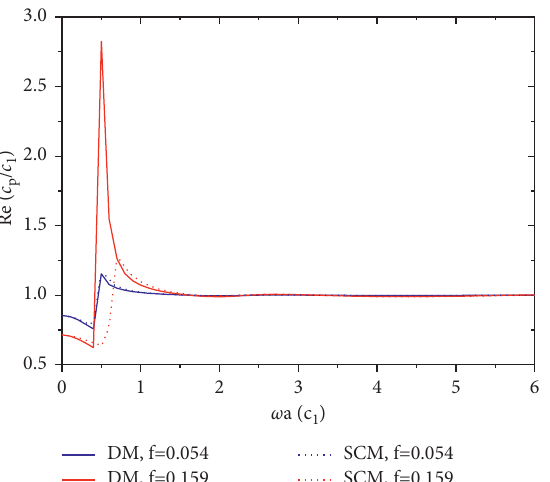
Figure 5: Comparison of ratios of the phase velocity in the composite material and matrix obtained by the differential method (DM) and self-consistent method (SCM) when quasi-P wave propagates in the composite material for inclusion volume fraction of 5.4% and 15.9% and δ � 0 .